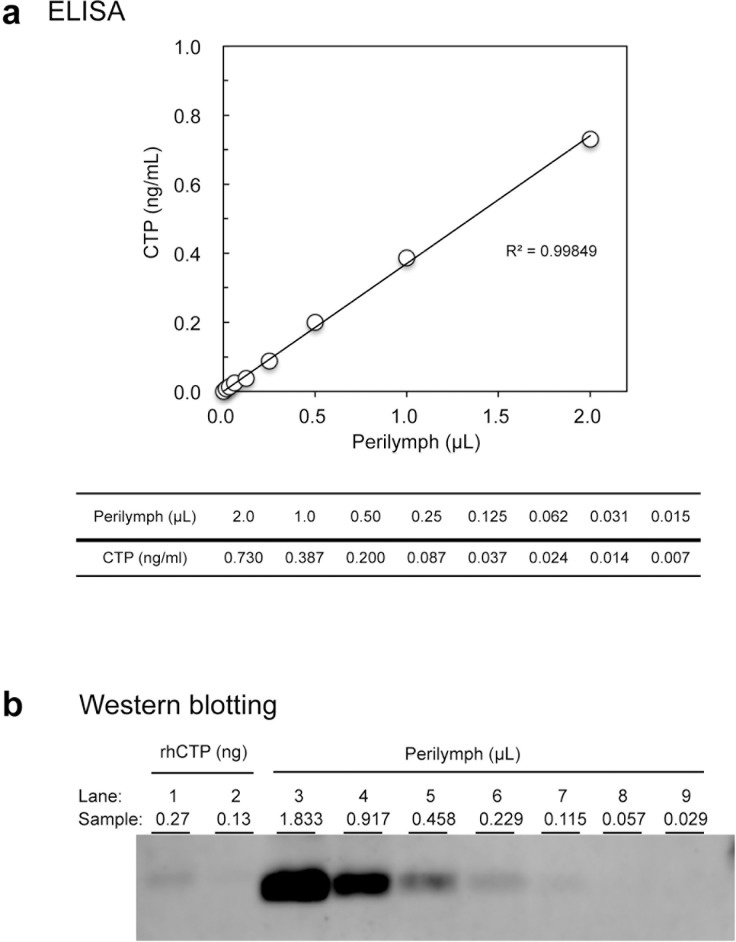
The dilution reproducibility of CTP in ELISA measurement, the CTP concentration of perilymph, and comparison with WB.We have collected leaked perilymph from the round window during cochlear implantation surgery from 3 cases, and the figure shows the representative results. Perilymph was serially diluted with saline by two-fold (8 samples) and each sample contained the following amounts of perilymph (ul) per well in ELISA: 2.0, 1.0, 0.50, 0.25, 0.125, 0.062, 0.031, and 0.015. The same perilymph was tested by WB. 2ul of perilymph was mixed with 98ul dilution buffer and it was serially diluted by two-fold (7 samples) and each sample contained the following amounts of perilymph: 1.833, 0.917, 0.458, 0.229, 0.115, 0.057, and 0.029ul/lane. The perilymph volume required to show comparable intensity with the high-spiked standard was determined. (A) The results of ELISA showed good dilution reproducibility (R2 = 0.99849), and the concentration of the perilymph was calculated to be 37.1 ng/ml. (B) The same perilymph was subjected to WB analysis and the perilymph volume required to show comparable intensity with a high-spiked standard of 0.229ul (lane 6) was determined.